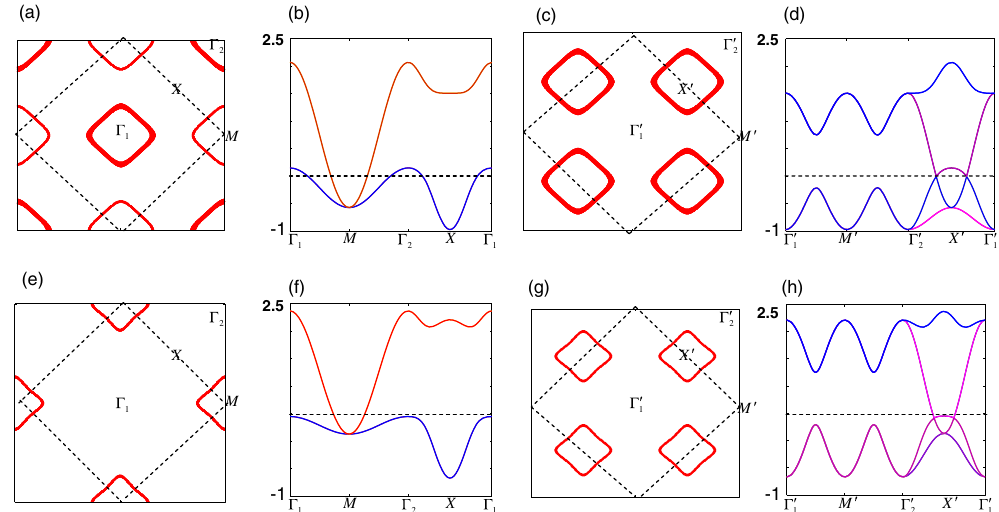
FIG. 4. The Fermi surfaces of each component when only parameters t 1 follows that of Fig. 2. The parameters are t 1 ¼ 0 : 24 , t 2 ¼ 0 : 52 , and (cid:5) ¼ (cid:2) 0 : 273 . The only difference in parameters between (a) and (e) is that t 0 2 ¼ (cid:2) 0 : 1 in (a) and t 0 2 ¼ (cid:2) 0 : 2 in (e). The y axis for (b),(d),(f),(h) is in units of